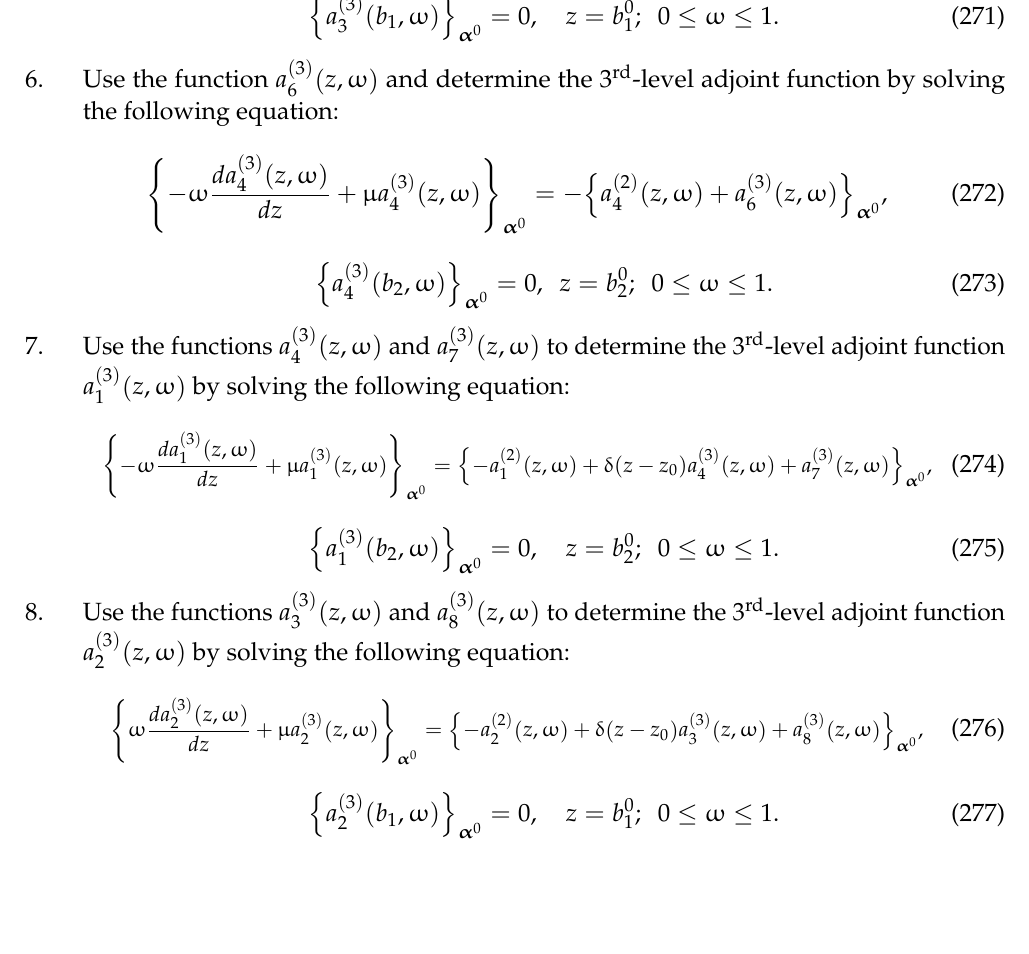
( 3 ) ( z , ω ) and determine the 3 rd -level adjoint function by solving 6